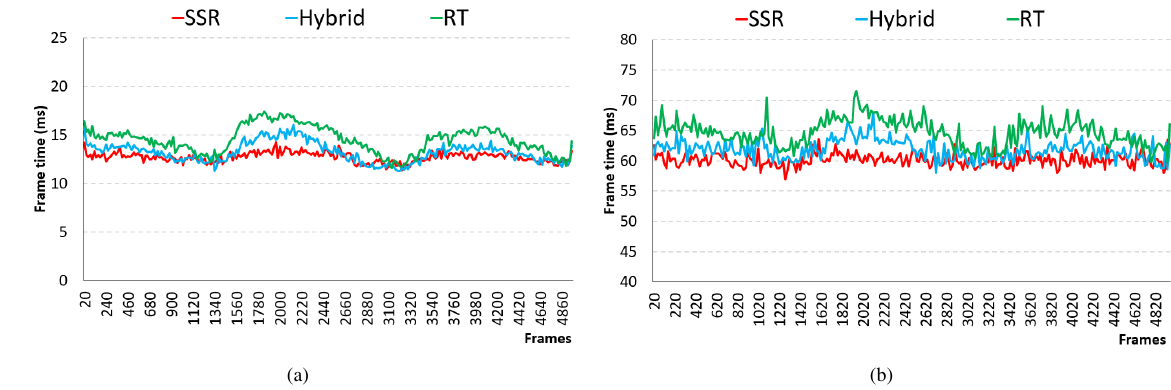
Fig. 12. Comparisons of the animation rendered using the SSR technique, our hybrid solution and ray tracing using KD-Tree for (a) static and (b) deformable meshes.